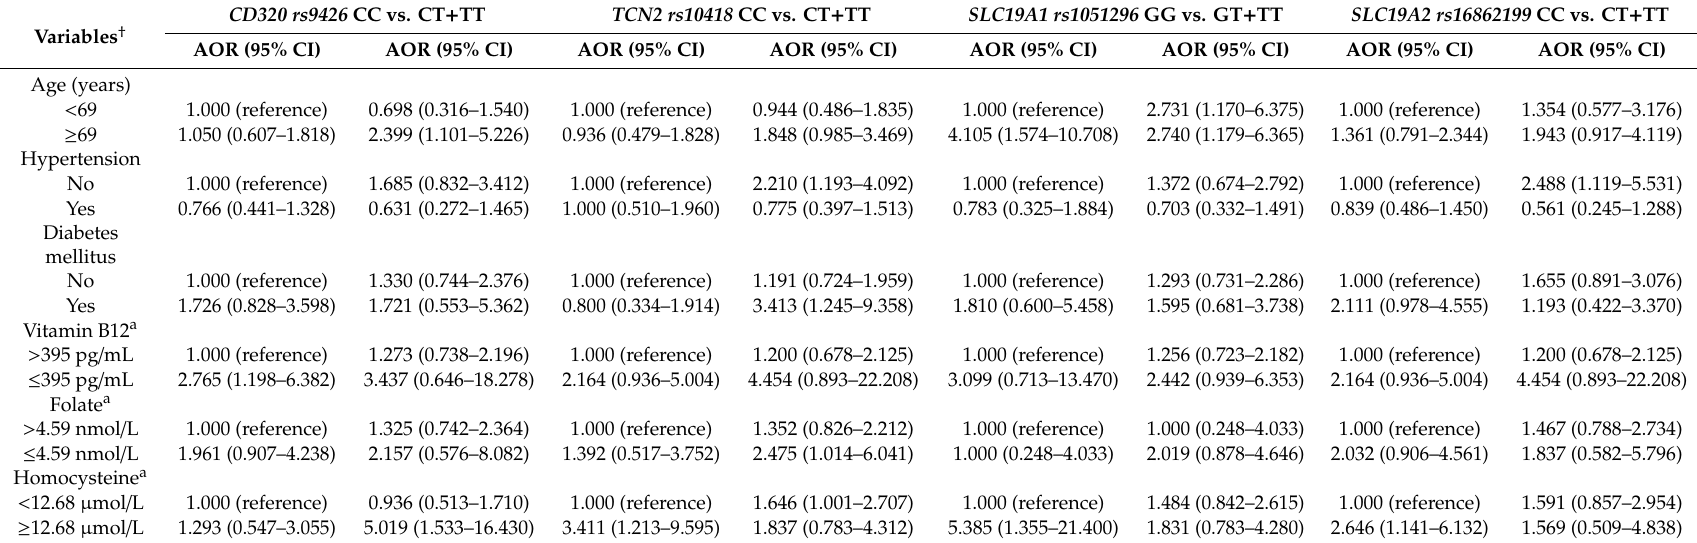
Table 4. Stratified analysis of osteoporosis incidence by interactions with age, hypertension, diabetes mellitus, and levels of vitamin B12, folate, and